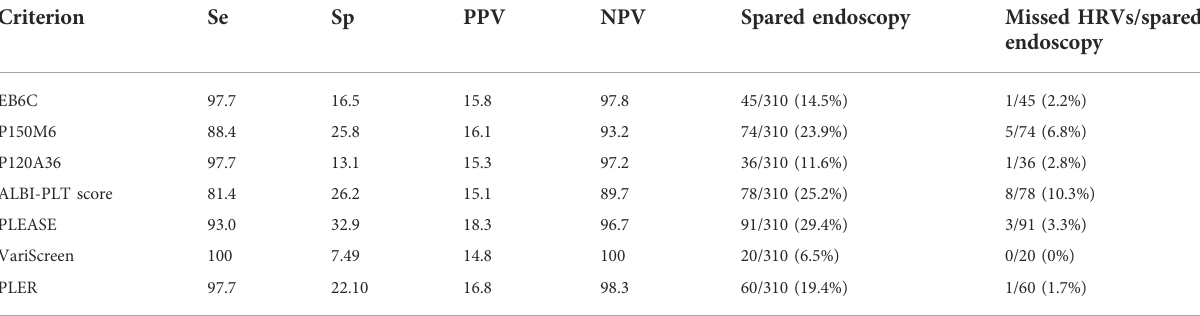
TABLE 4 Performances of the PLT:LSM ratio and NITs for excluding HRVs in patients with HBV-related compensated cirrhosis beyond Baveno VI criteria.